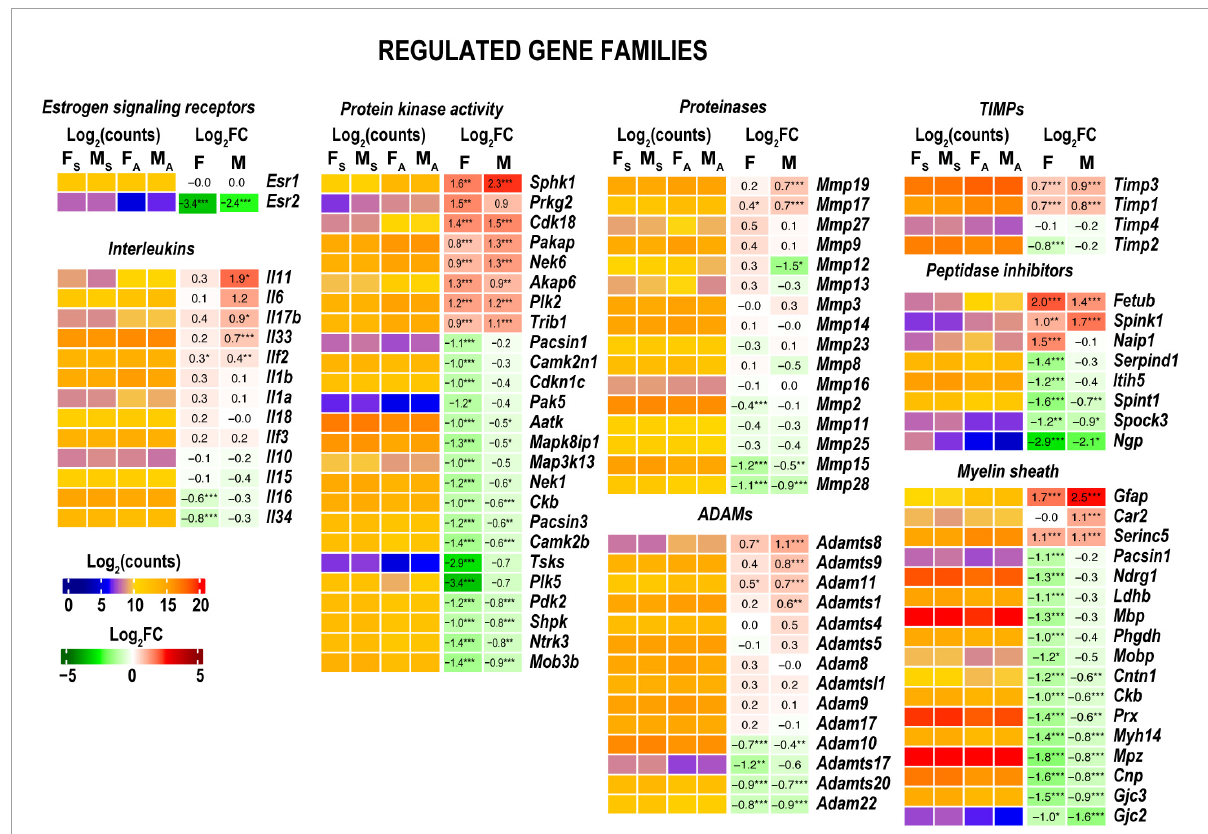
FIGURE6 Regulated gene families. Heatmaps on panels display normalized log 2 (counts) in sample groups (F S , female sham; M S , male sham; F A , female axotomy; M A , male axotomy) and log 2 FC in female (F) and male (M); [ n = 6 mice/group, 2 mice/sample (pooled), 3 sample/group] of respective DEGs. Log 2 FC significance was determine in DESeq2 using Wald test: * p ≤ 0.05; ** p ≤ 0.005; *** p ≤ 0.0005. DEGs were sorted by log 2